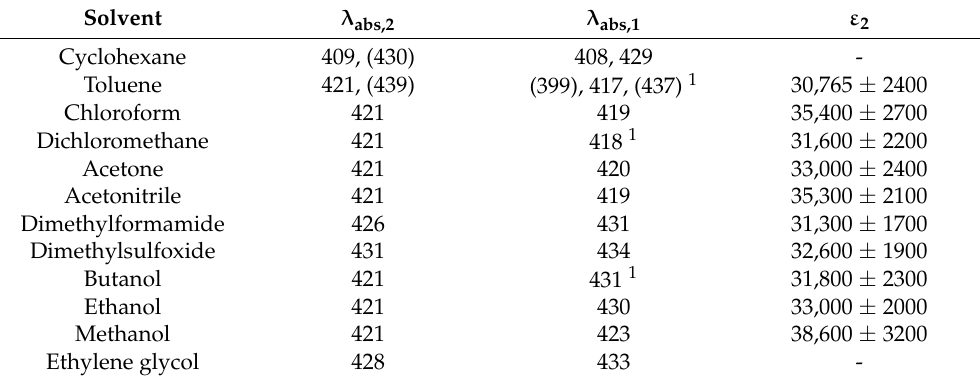
Table 2. Absorption peak wavelength of 2 in the different solvents of Table 1, λ abs, 2 , is compared to that of 1 , λ abs, 1 , reproduced from [38] for the sake of straightforward comparison. The molar extinction coefficient of 2 at the absorption peak, ε 2 , is also reported.